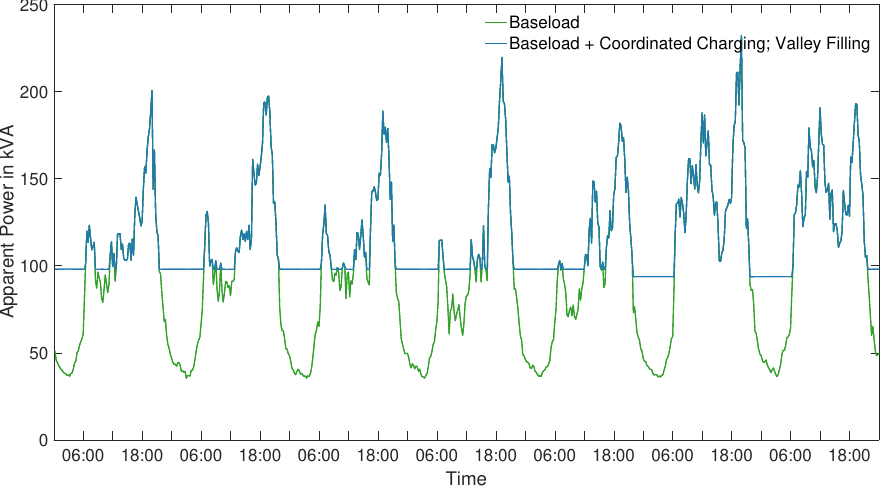
Figure 10. Baseload and coordinated charging (CC) valley filling (VF), apparent